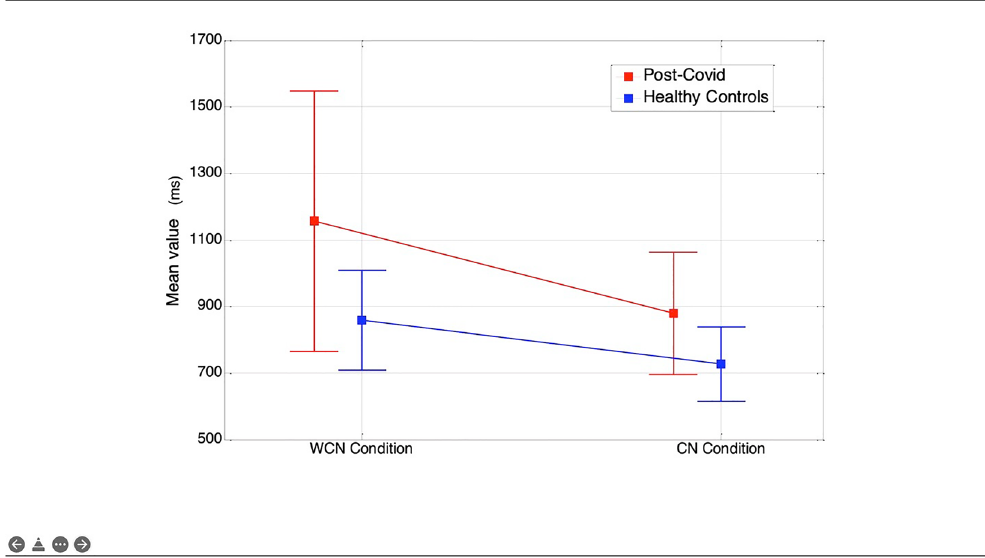
Figure 1. Mean value of RTs during stroop task in WCN and CN conditions, in PCS-pt and HC.